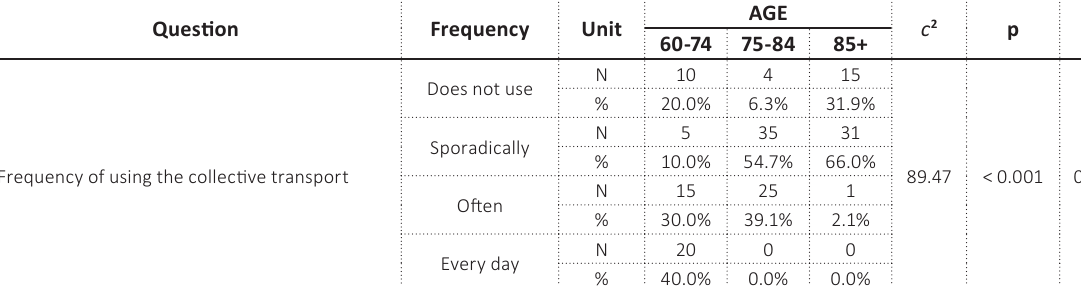
Source: Developed by the author based on the